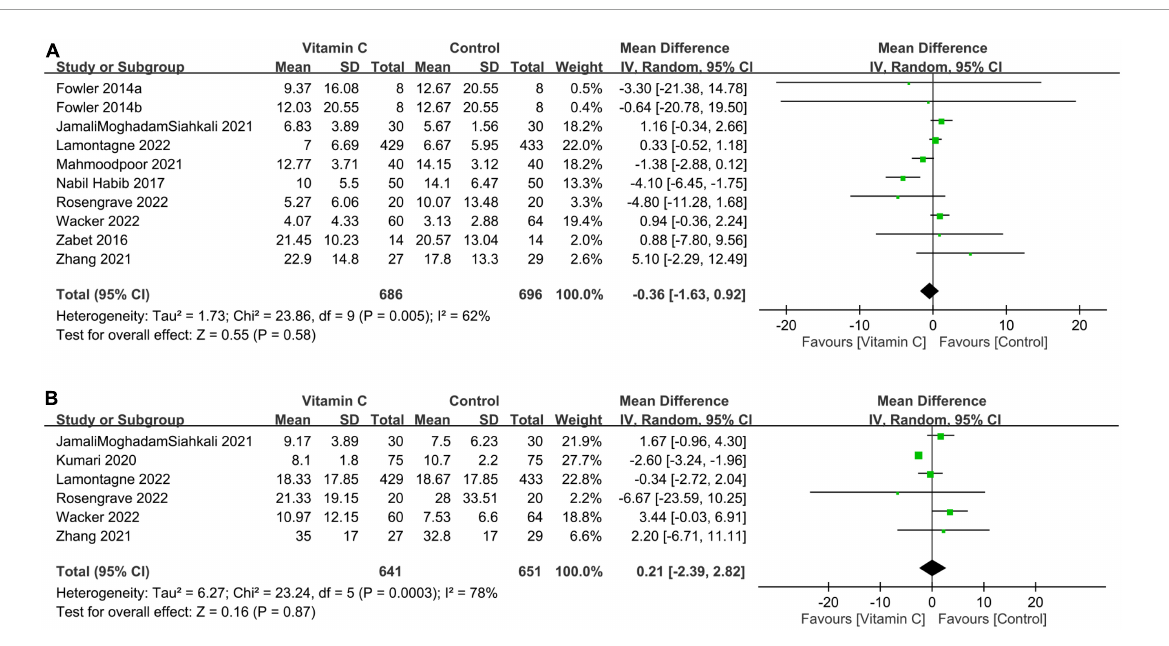
only may bias our results but may also explain the lack of a universal guideline for vitamin C use in the critical care